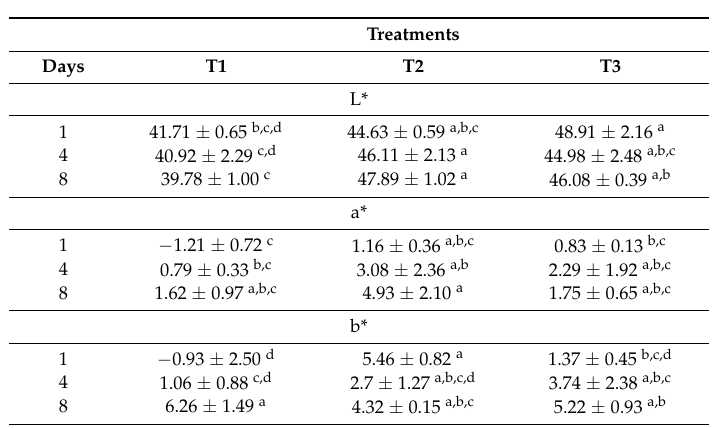
Table 1. The effect of surimi-based coating on the values of L*, a* and b* of shrimp during storage at 4 ± 1 ◦